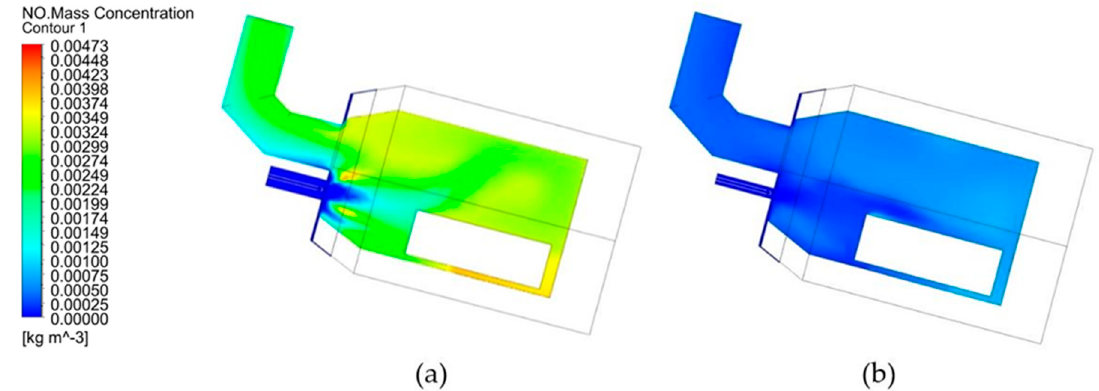
Figure 14. Model results: distribution of NO mass concentration contours. ( a ) OEC technology, ( b ) OEC technology +modification of burner.